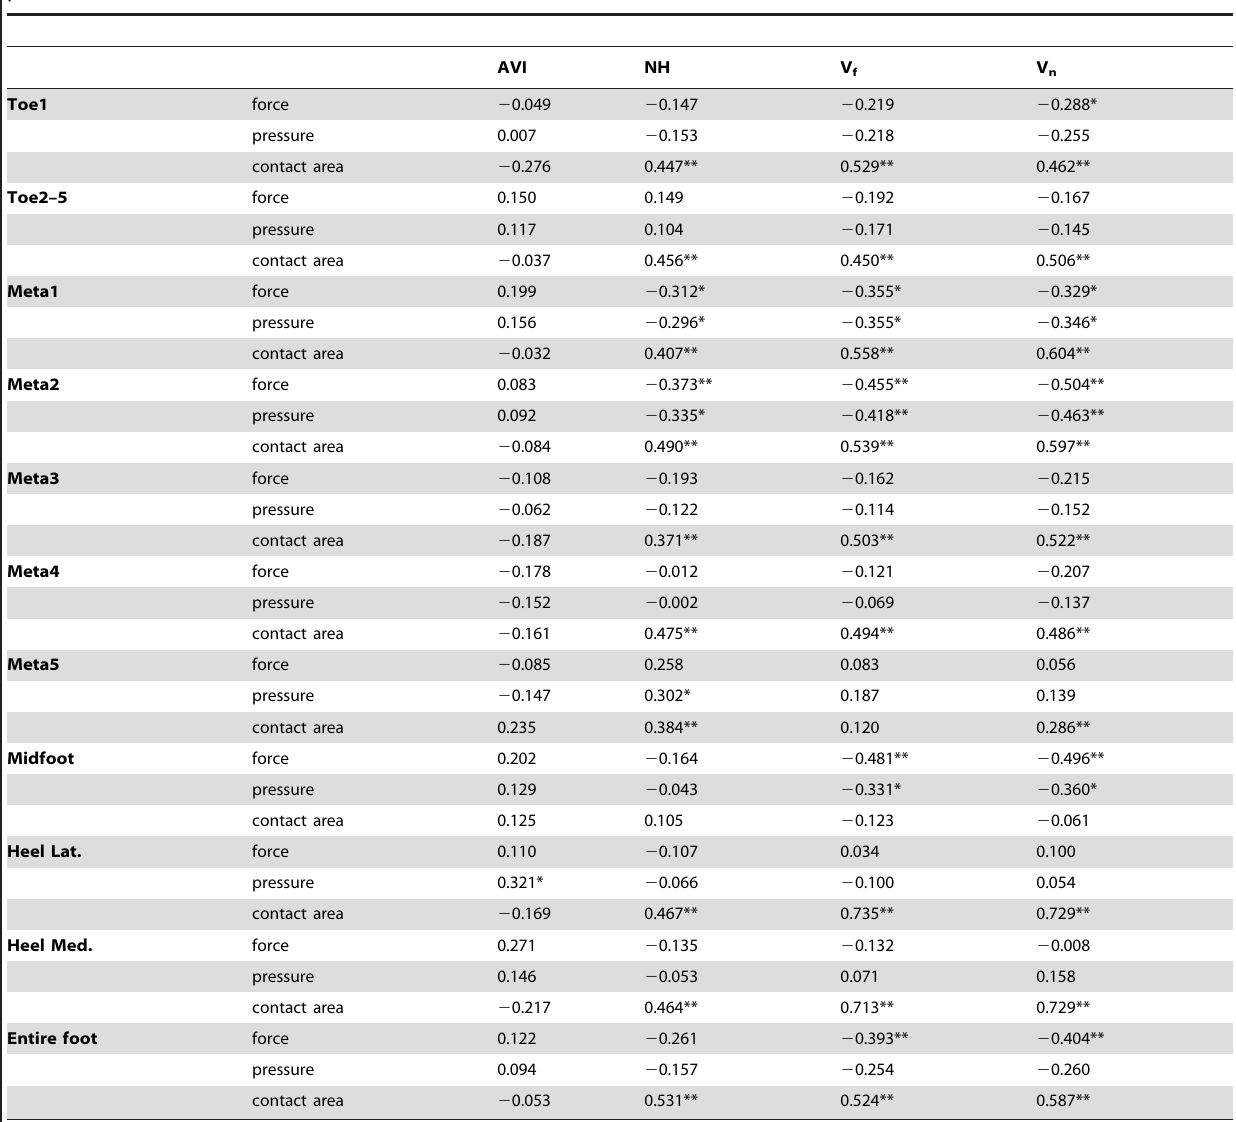
Table 4. The correlation between arch parameters and force, pressure and contact area under ten foot regions during the stance